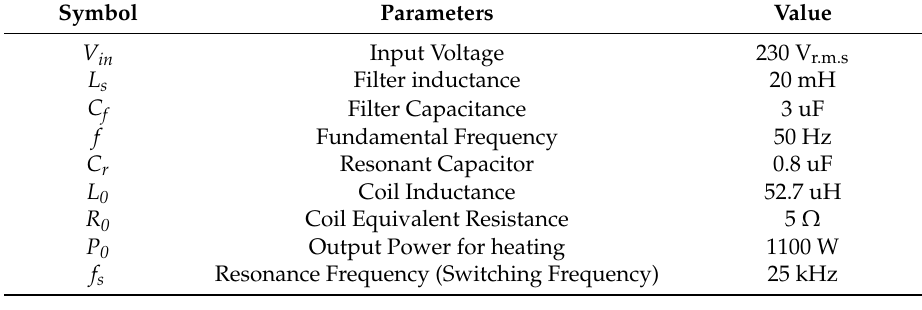
Table 2. Parameters used for the simulation.